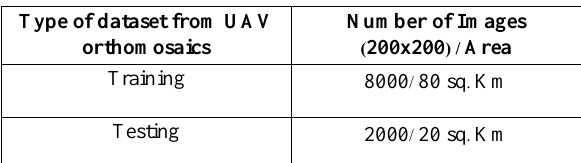
Table 2 . 2 : Training and Testing dataset in case of Private orthomosaics